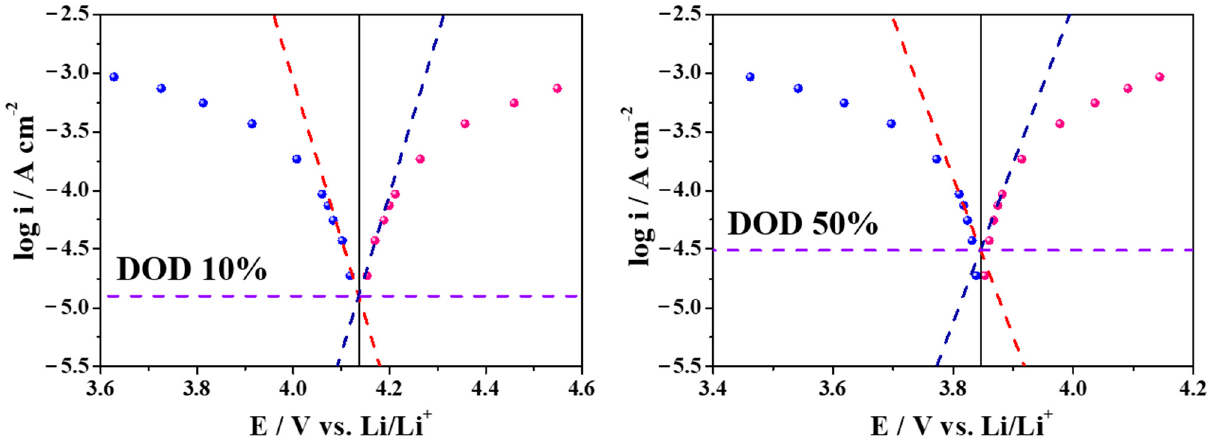
Figure 4. Tafel plots of the NCM622-Li 6 PS 5 Cl system at 10% DOD and 50% DOD (red- and royal- colored dashed lines are Tafel slops upon the charging (blue dots) and discharging (red dots), respectively; violet dashed lines refer to the exchange current densities).